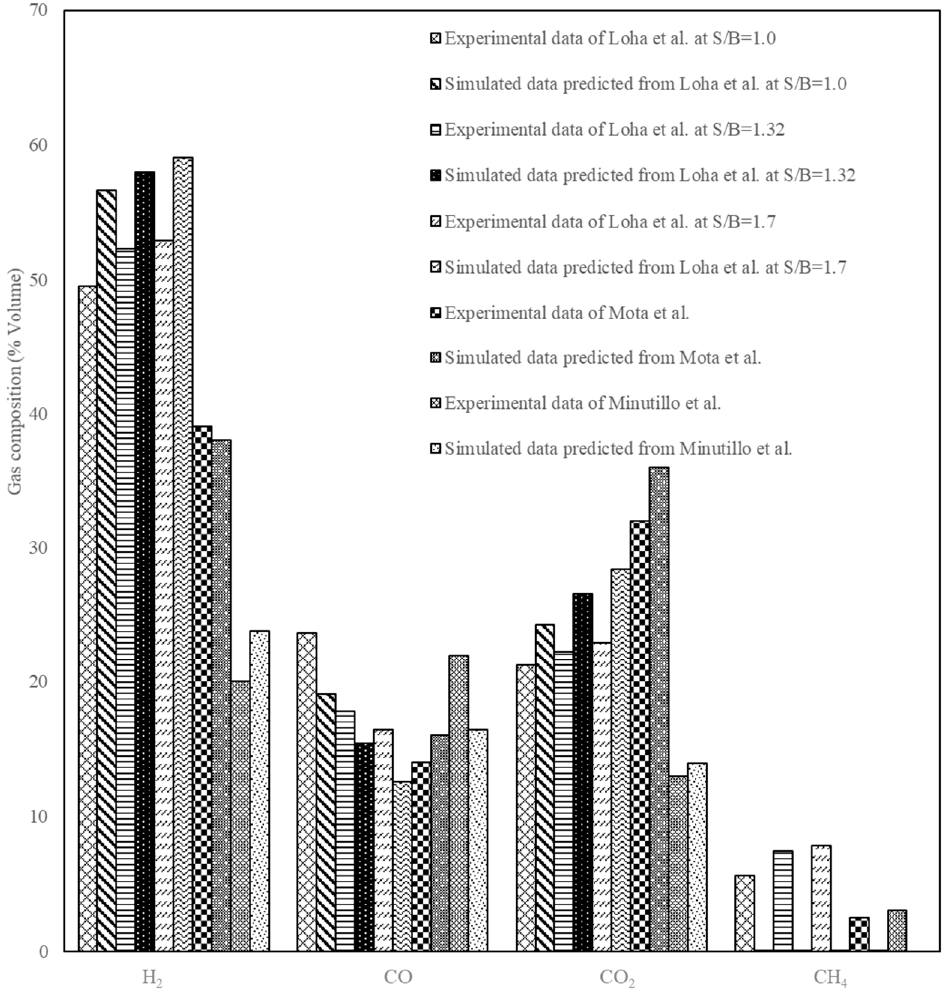
Figure 2. Comparison of the syngas composition obtained from the model prediction and experimen- tal data of Loha et al. [27], Mota et al. [28], and Minutillo et al. [29].